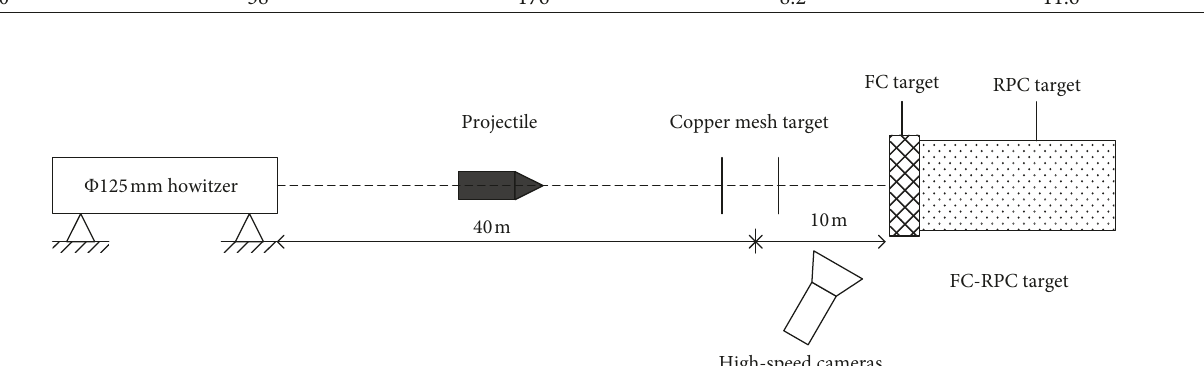
Figure 5: Arrangement diagram of the test.